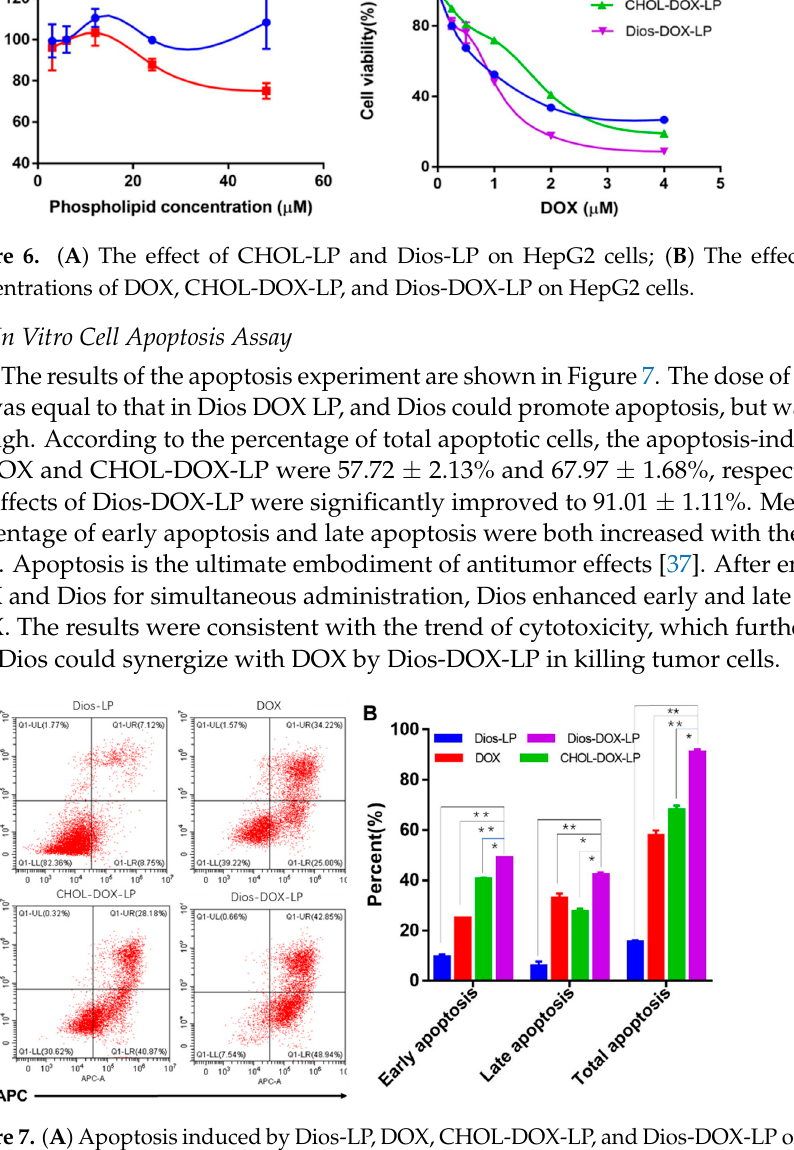
Figure 7. ( A ) Apoptosis induced by Dios-LP, DOX, CHOL-DOX-LP, and Dios-DOX-LP on HepG2 cells; ( B ) Results of apoptotic percent on HepG2 cell induced by Dios-LP, DOX, CHOL-DOX-LP, and Dios-DOX-LP (*: there was significant difference, p < 0.05; **: there was significant difference, p <